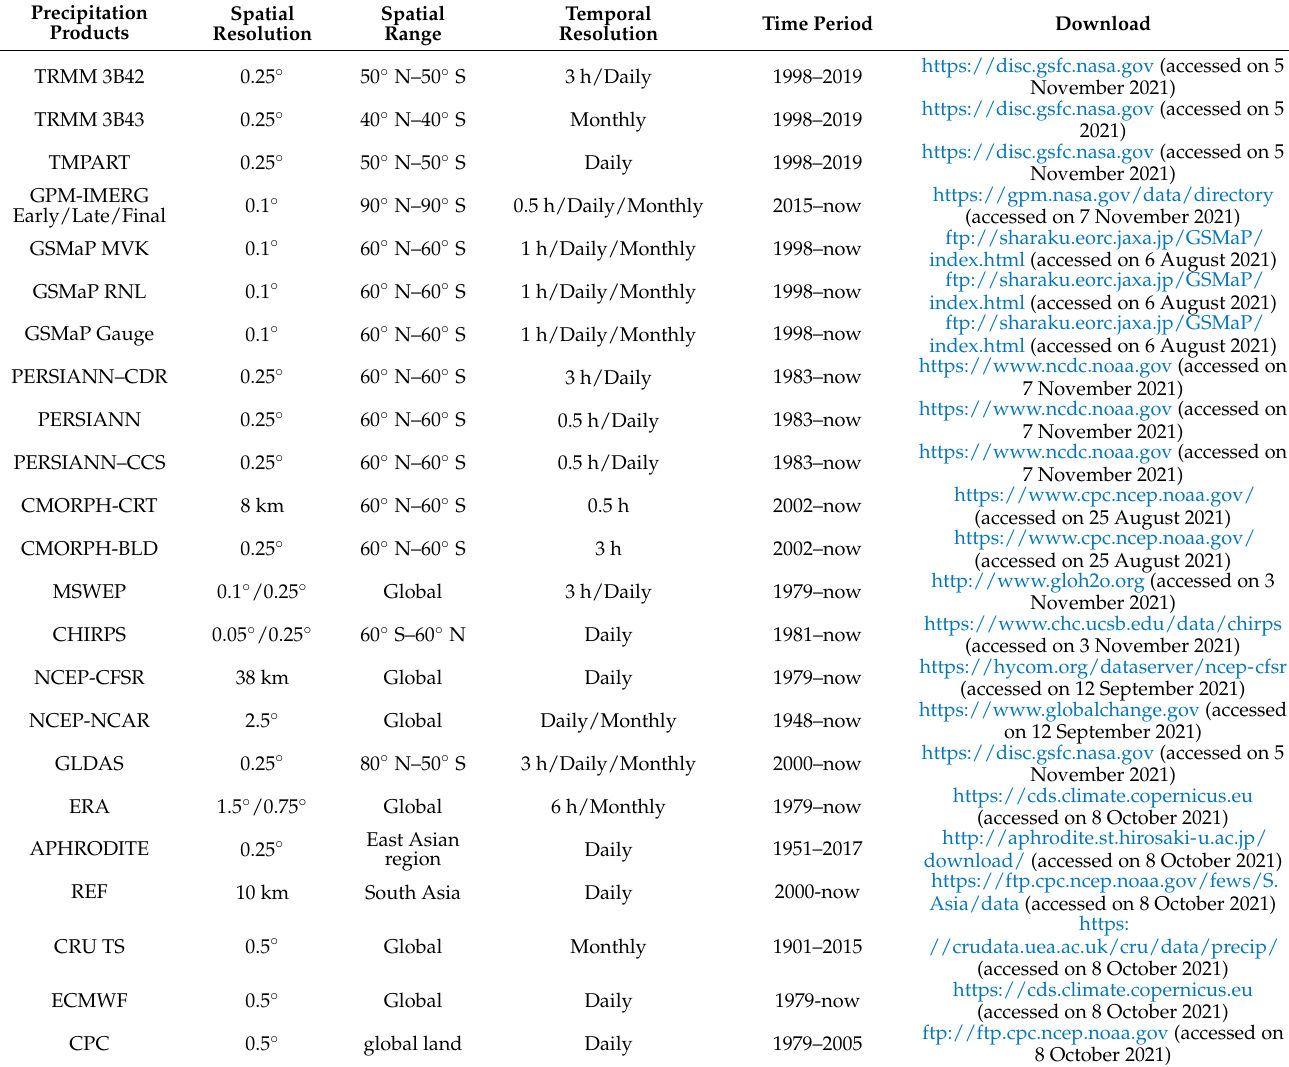
Table 1. Overview of precipitation data products mentioned in the Introduction